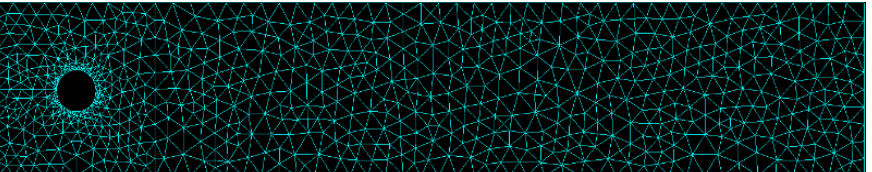
Figure 3. The simulated geometry of the cylinder and notations for the boundary conditions of the 2D test case.